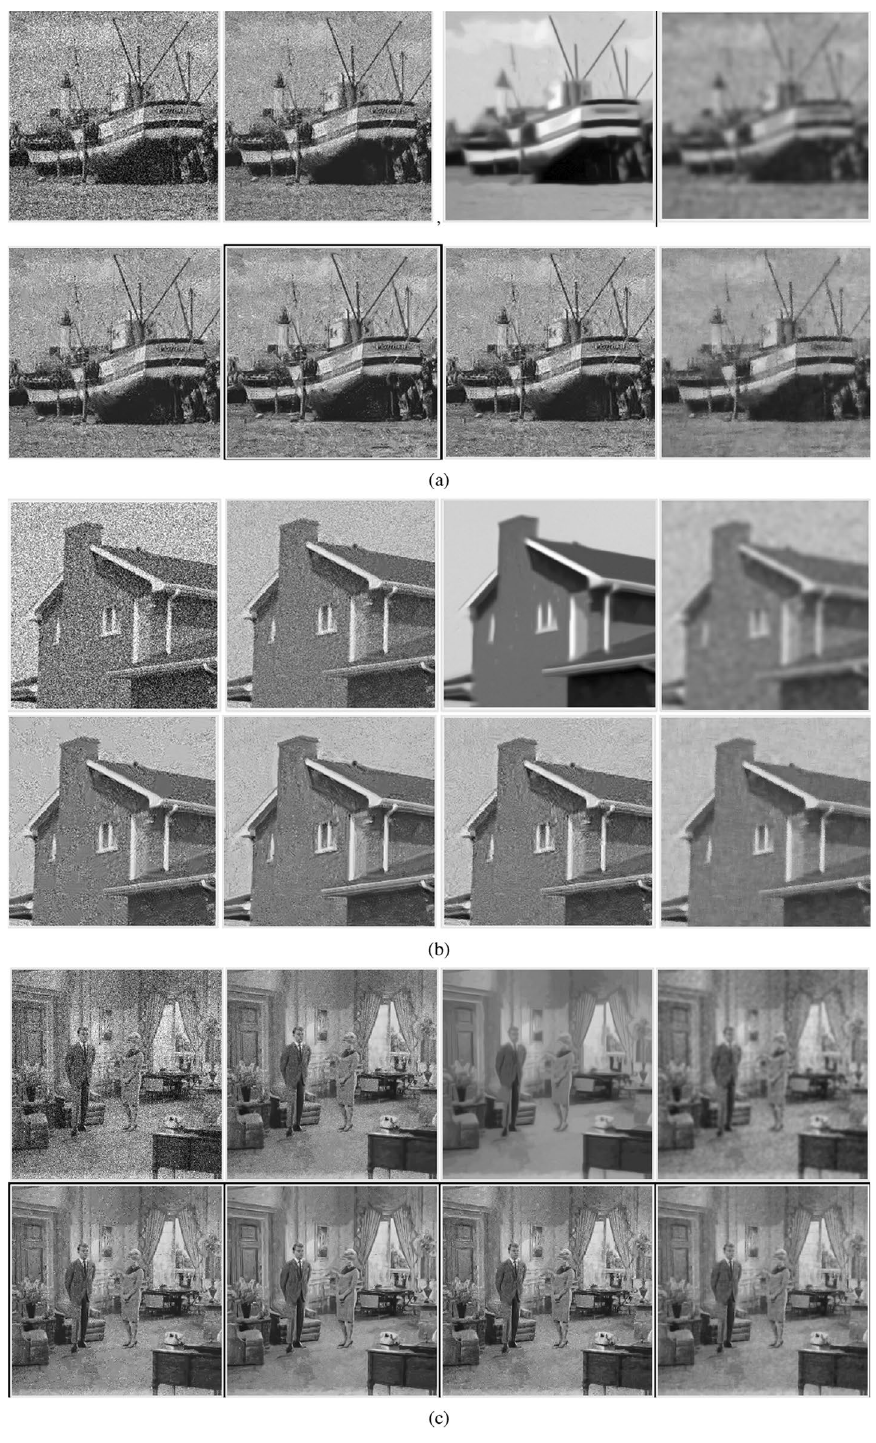
Figure 10. The results of various denoising methods. ( a ) Boat (σ 2 = 25) ( b ) house (σ 2 = 30) ( c ) Couple (σ 2 = 35). From left to right and top to bottom are noise image, NCSR, MCWNNM, QM-based, TWSC, NLH, BM3D and the proposed method